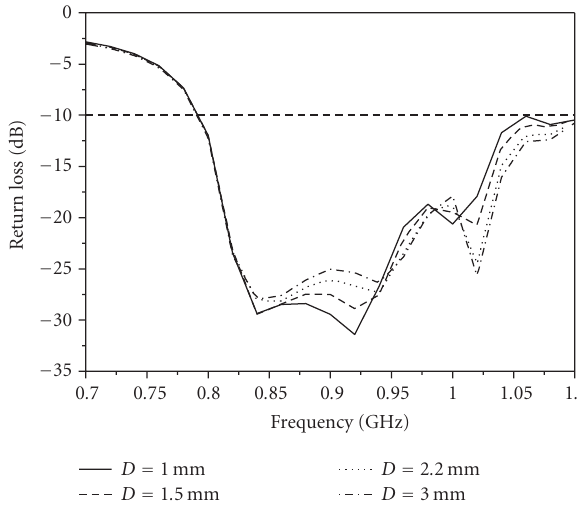
Figure 6: E ff ect of the position of the feeding probes on impedance matching.